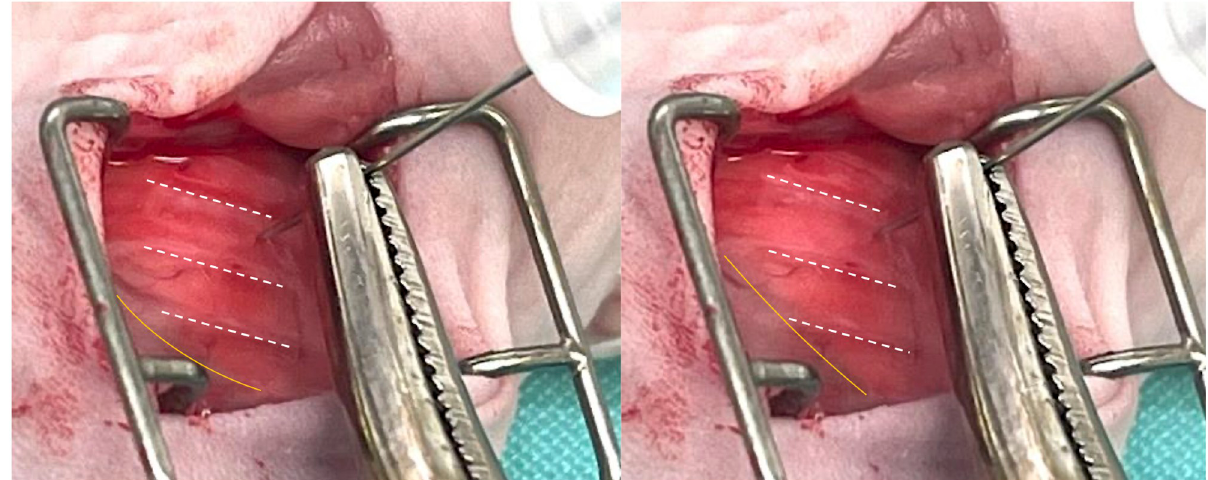
Fig 2. Image of the incision site featuring the lung visible through the chest wall. Images show a lung on exhale (left) and inhale (right). Syringe is advanced to a depth of 4 mm, measured from tip of bevel to lung surface. While not shown in this image for clarity, locking forceps were fixed 4 mm from the tip of the needle to impede the syringe from being inserted further than the acceptable